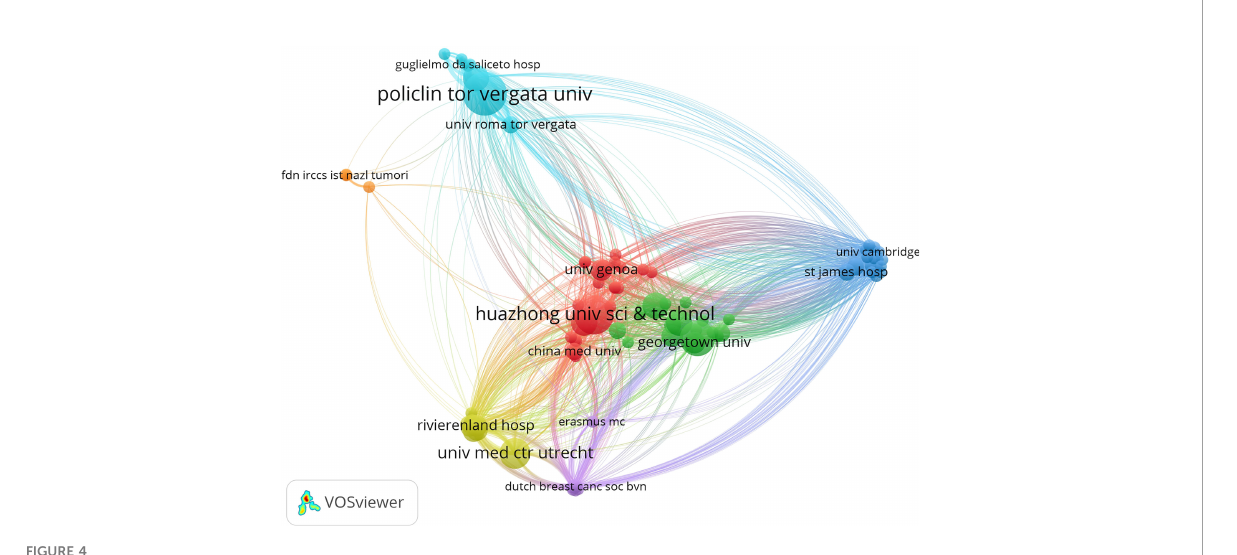
FIGURE 4 The map of the institution ’ s collaborative